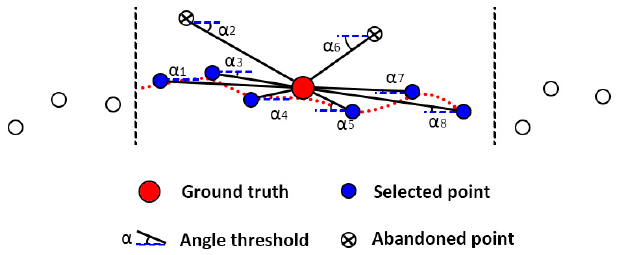
Figure 2. The schematic diagram of morphology-based DTM generation method. If the slope between the ground point and a candidate point is smaller than a (global or local) slope threshold, then this candidate point is set as a ground point. Otherwise, this candidate point is set as a non-ground point.